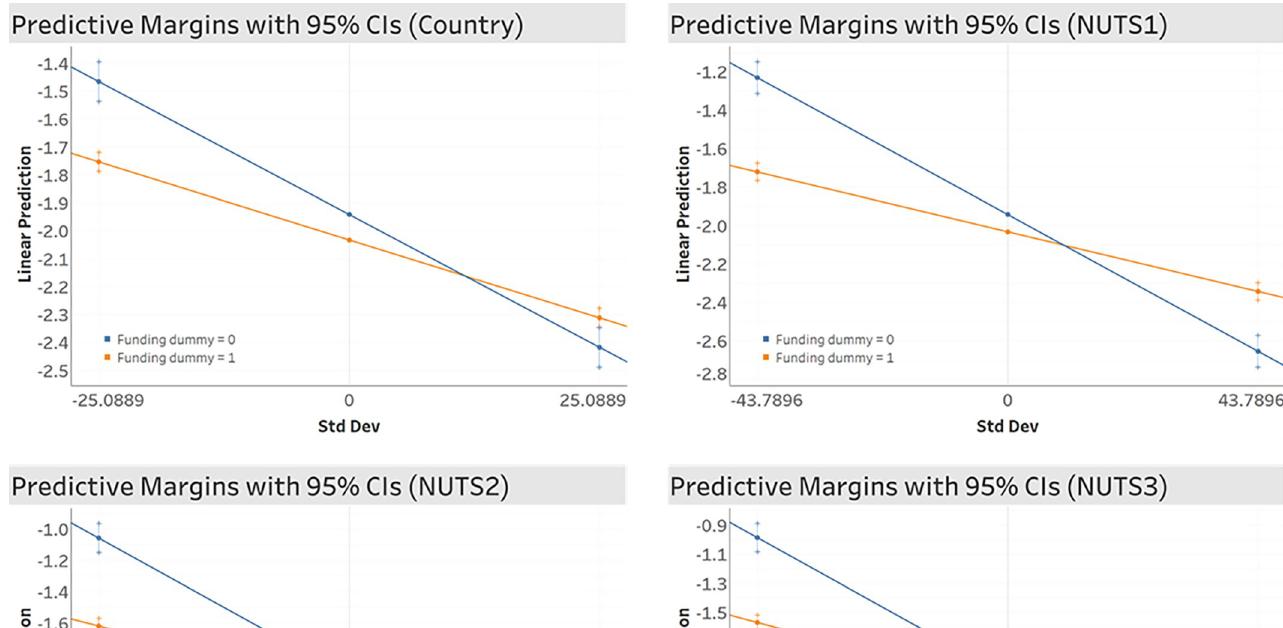
Fig 6. Margins plots for funding dummy and novelty. Std Dev: Standard Deviation of collaboration